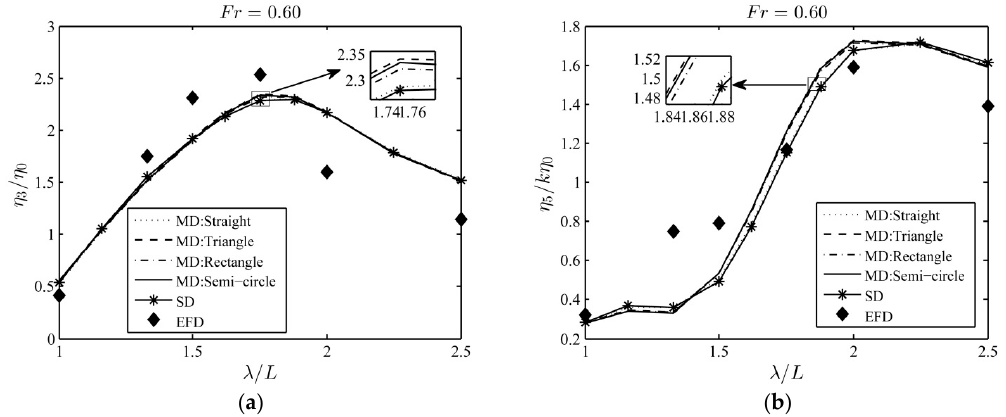
Figure 4. Comparison of motion response of the Delft 372 catamaran using the multi-domain 2.5D method with various splitters (straight, triangle, rectangle, semicircle) with results from single- domain 2.5D methods and experiments. λ is the wavelength. ( a ) Heave response amplitude operator (RAO); ( b ) Pitch RAO.